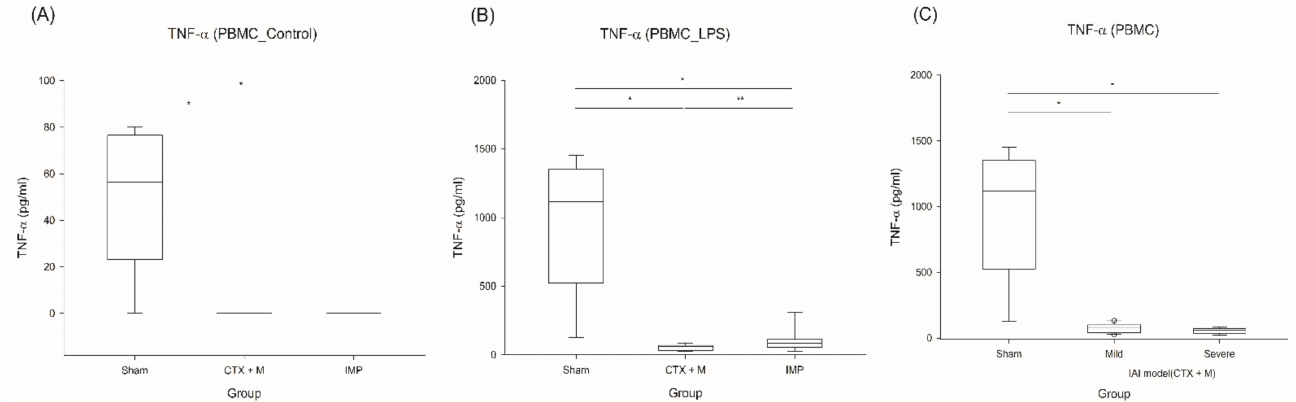
Figure 5. Effects of different antibiotics on endotoxin tolerance of PBMC stimulated by LPS. ( A ) Baseline TNF- α in PBMCs after severe IAI induction, ( B ) endotoxin tolerance of PBMCs in severe IAI model, ( C ) endotoxin tolerance of PBMCs in mild or severe IAI model with CTX + M. n = 5 for sham, n = 6–11 for other groups; * p < 0.05 compared with sham, ** p compared with CTX + M model. IAI, intraabdominal infection; CTX + M, ceftriaxone with metronidazole; IMP, imipenem; PBMC, peripheral blood mononuclear cell; LPS,